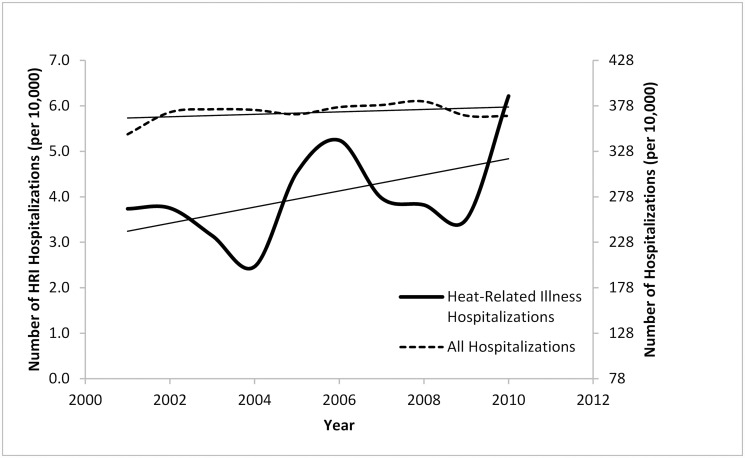
Heat-Related Illness versus All Hospitalizations Rates, Summer 2001–2010.The dotted line represents the rate of all hospitalizations during the study time period which remained approximately level over time. The solid line represents heat-related illness hospitalizations which although varied by year have steadily increased over the study period.